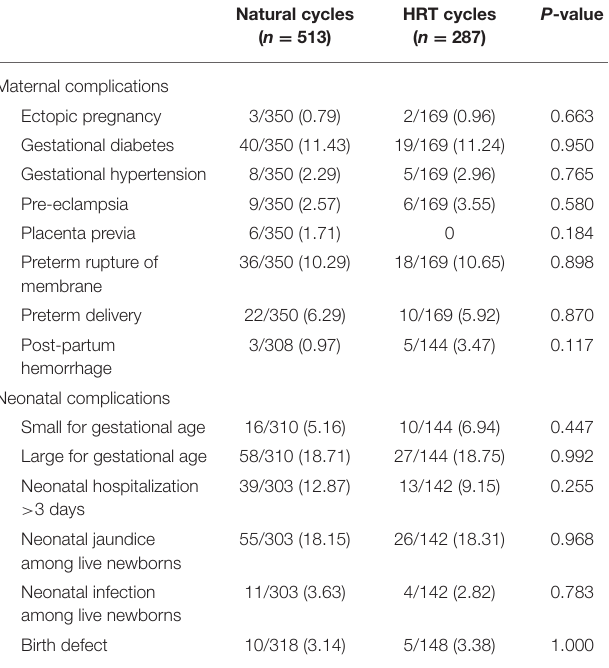
TABLE 3 | Maternal and neonatal complications.